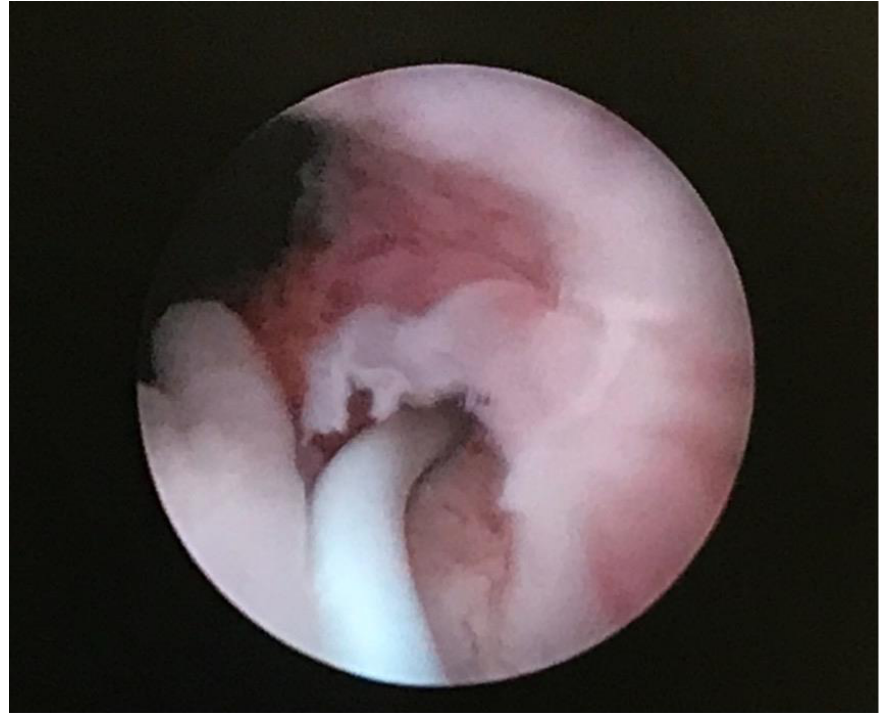
Figure 6. Ectopic orifice located below bladder neck probed with SJ catheter.